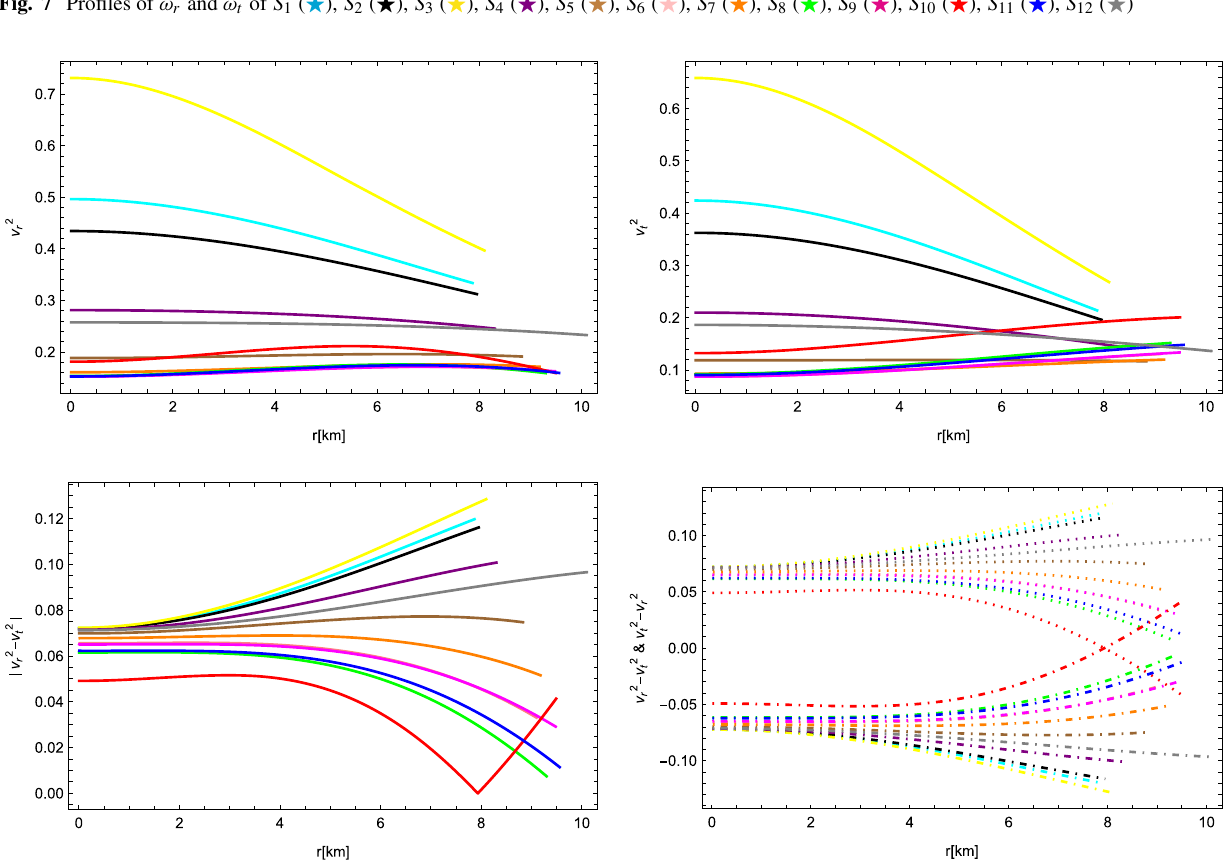
Fig. 8 Behavior of speeds of sound parameters, and Abreu condition of S 1 ( (cid:2) ), S 2 ( (cid:2) ), S 3 ( (cid:2) ), S 4 ( (cid:2) ), S 5 ( (cid:2) ), S 6 ( (cid:2) ), S 7 ( (cid:2) ), S 8 ( (cid:2) ), S 9 ( (cid:2) ), S 10 ( (cid:2) ), S 11 ( (cid:2) ), S 12 ( (cid:2)